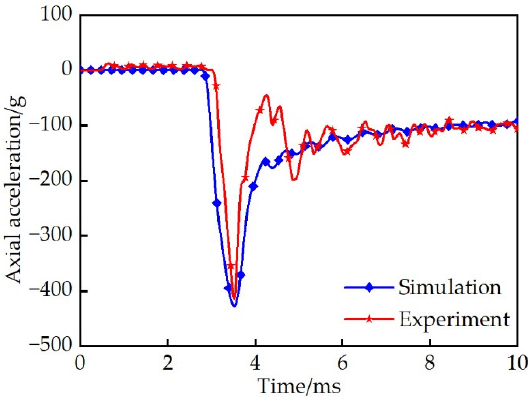
Figure 6. Comparison of axial acceleration between experiment and simulation.